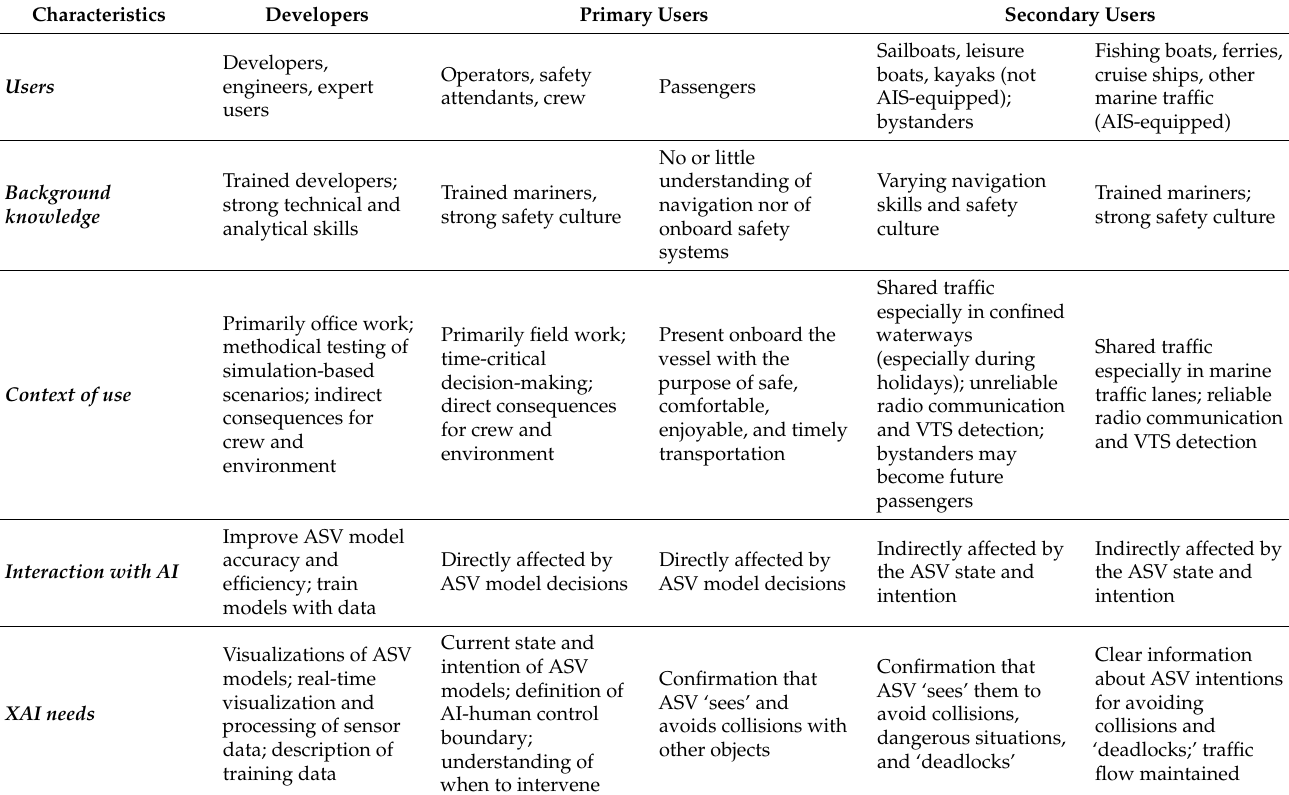
Table 3. Characteristics of developers and primary/secondary users of ASVs in the context of XAI needs.